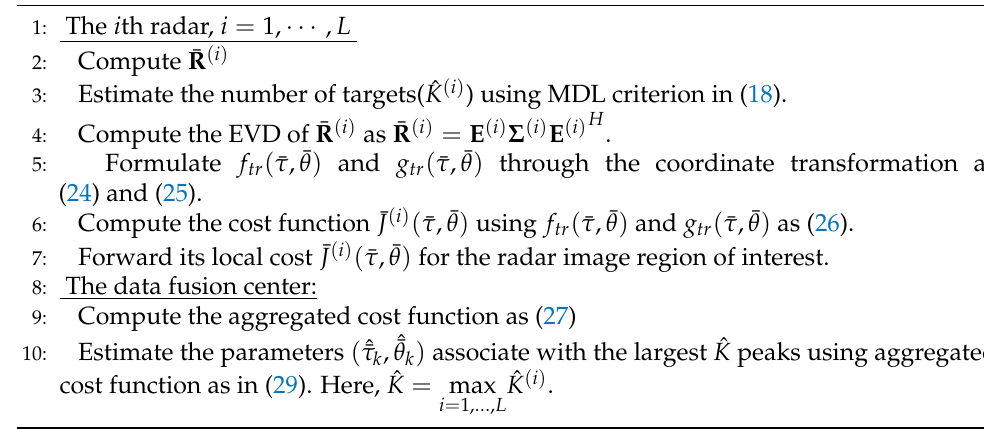
Algorithm 1 Distributed 2D MUSIC algorithm with coordinate